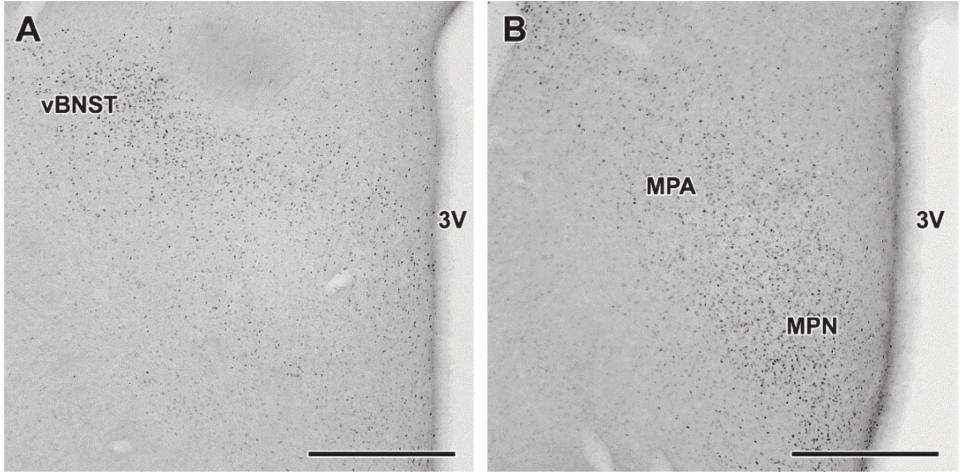
Figure 6. Distribution of Androgen Receptor (AR) detected by immunohistochemistry. Immuno- labeling was performed in brains of mothers to detect AR in the preoptic region at 2 adjacent antero-posterior level ( A , B ). AR-immunoreactive cells (black dots) are abundant in MPN, MPA and vBNST. Scale bars = 500 µ m. Further abbreviation: 3V—third ventricle.